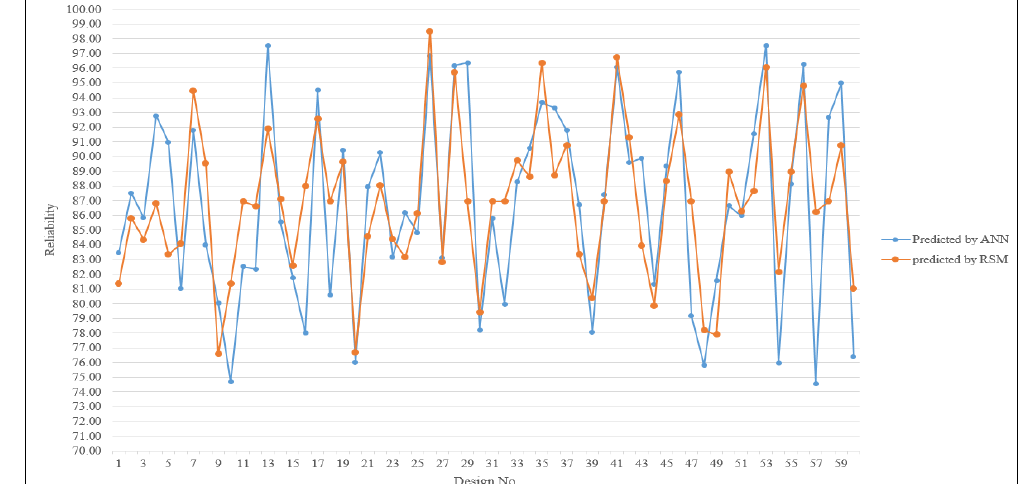
Fig. 5. The original reliability and the predicted